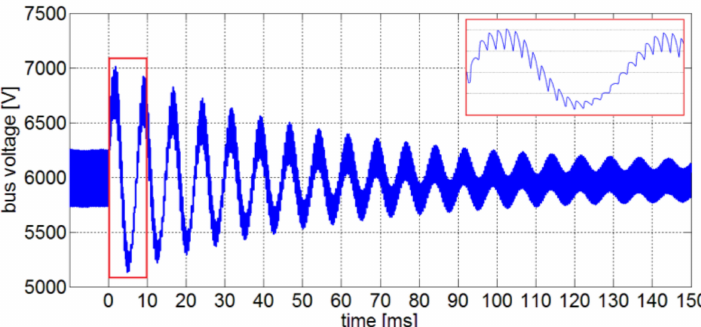
Figure 10. Bus voltage transient in Case 3 (each Y-division is 500 V in zoomed graph).